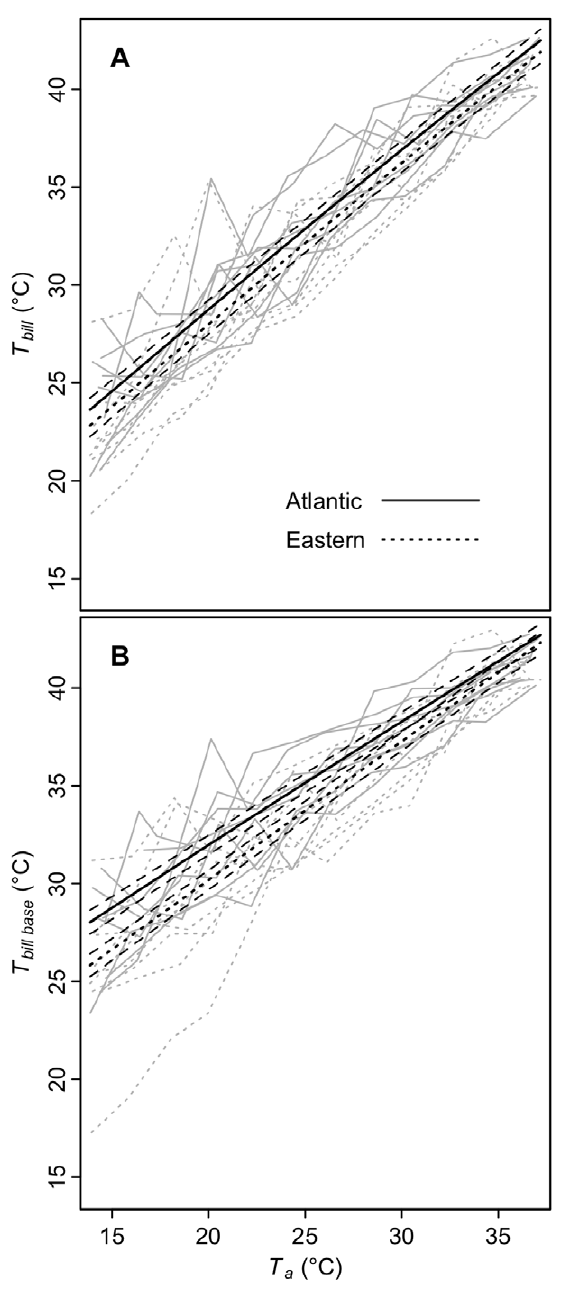
Table 5. Linear mixed models describing heat loss through the bill as a percent of heat of heat lost through all body surfaces (percent Q bill